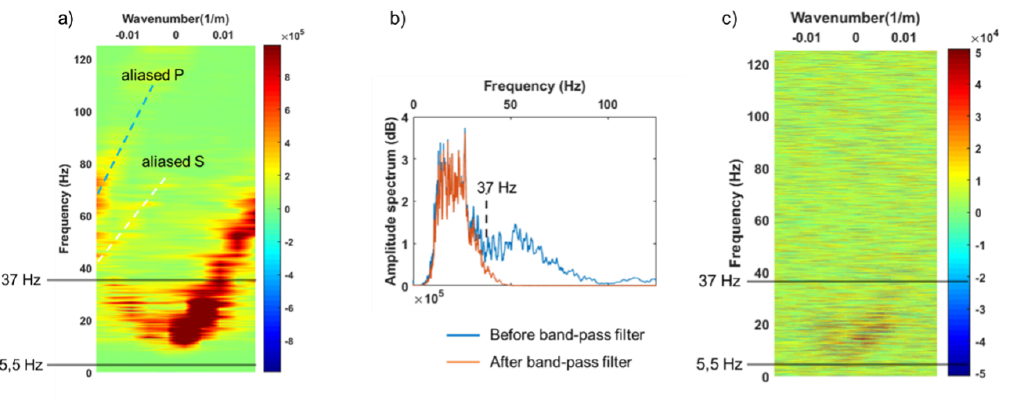
Figure 7. F - k analysis of check shot and noise data. ( a ) F - k plot shows wrap-around indicating aliased signal. ( b ) Frequency content of check shot data before and after the band-pass filter to suppress aliasing. ( c ) F - k plot of noise data. Its spectral distribution resembles the check shot data.